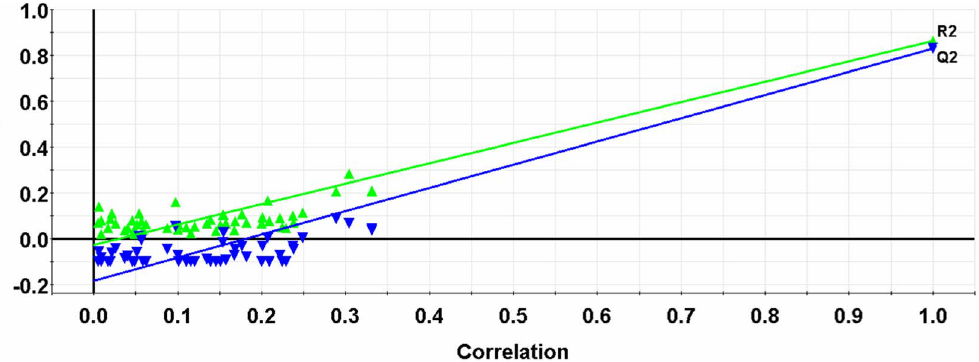
Figure 3. Plot of the 50-random-permutation validation for the GA-PLS model of BTDs. The intercepts of the R 2 - and Q 2 -regression lines with the ordinate axis are 2 0.026 and 2 0.183, which are below limits of R 2 , 0.300 and Q 2 , 0.050, respectively.